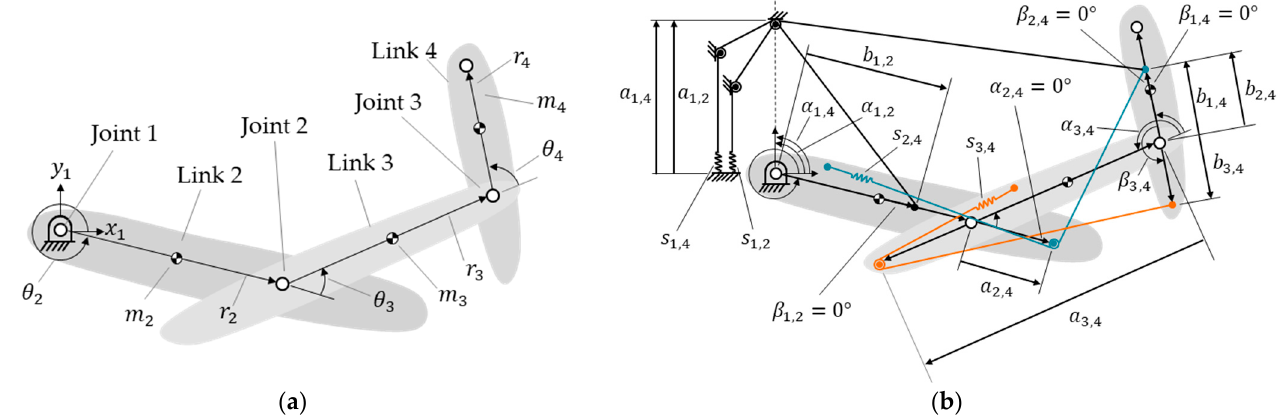
Figure 4. A 4-link manipulator: ( a ) without spring; ( b ) with four springs: s 1,4 , s 1,2 , s 2,4 , and s 3,4